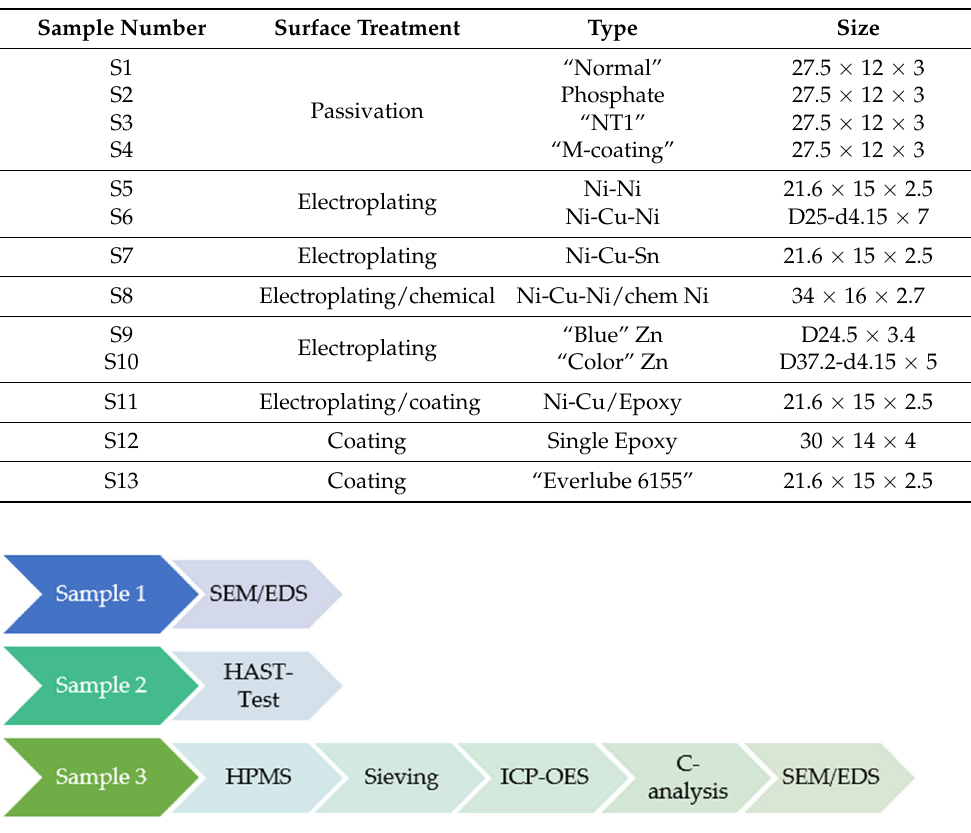
Table A1. Geometry and coating data of the investigated samples.